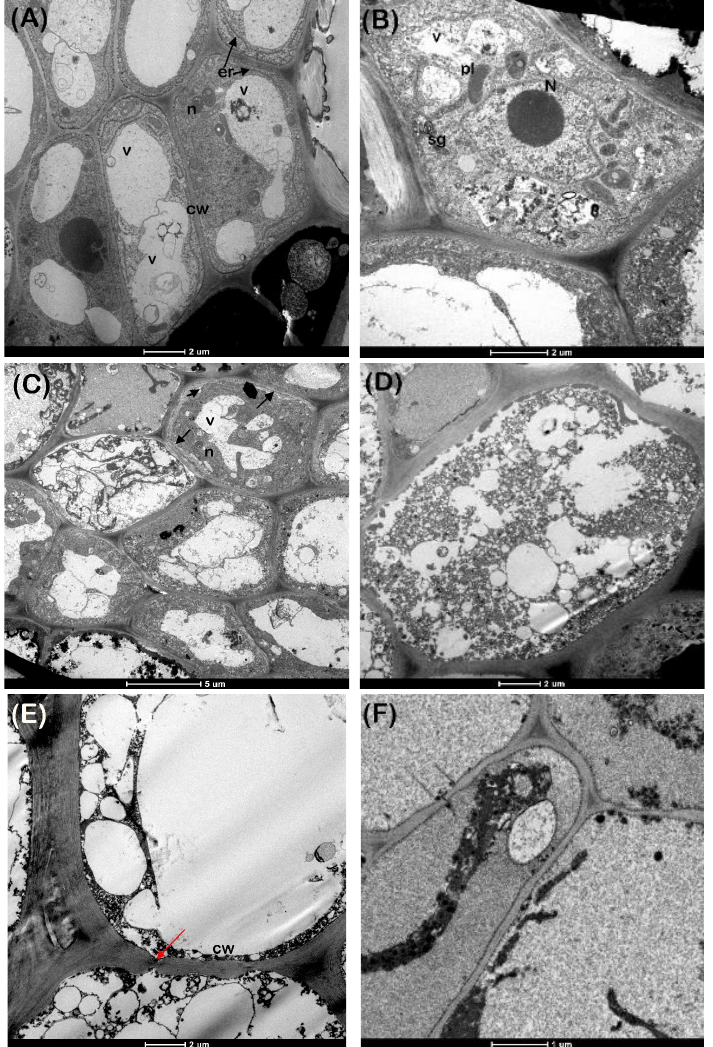
Figure 5. The ultrastructure of fresh Syzygium maire embryonic axes (EAs) typically had large vacuoles (V), irregularly shaped nuclei (N) and well-developed endoplasmic reticulum (er) ( A ). Good ultrastructural preservation was evident following desiccation to <0.3 g/g ( B ), although plasmolysis (arrows) was evident together with an increase in the vacuole (v) ( C ). Disintegration of cells ( D ), as well as damage to cell membranes ( E ), were evident following freezing of EAs with MC > 0.75 g/g, while cell membranes appeared intact after freezing of EAs desiccated to <0.3 g/g ( F